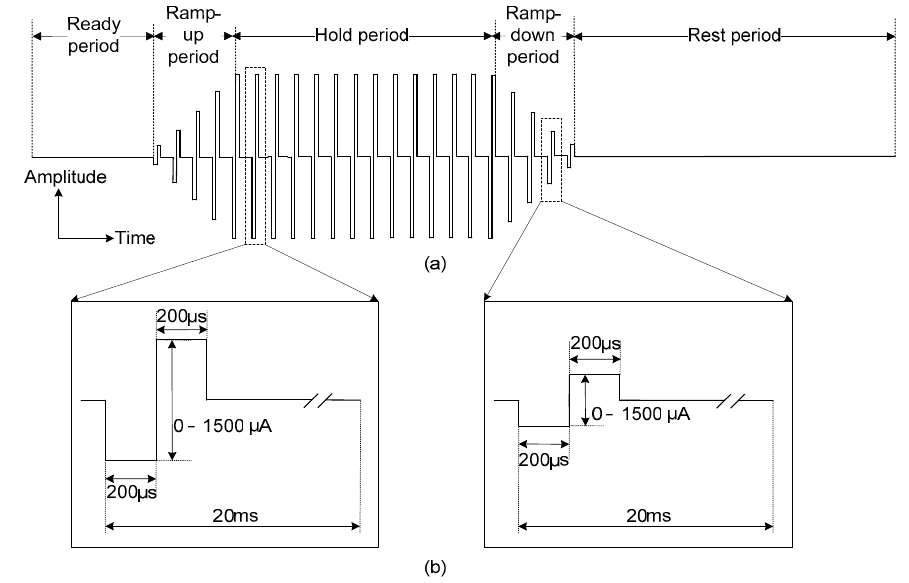
Figure 5. Stimulation waveform: ( a ) including ramp-up and ramp-down periods and ( b ) details of a single